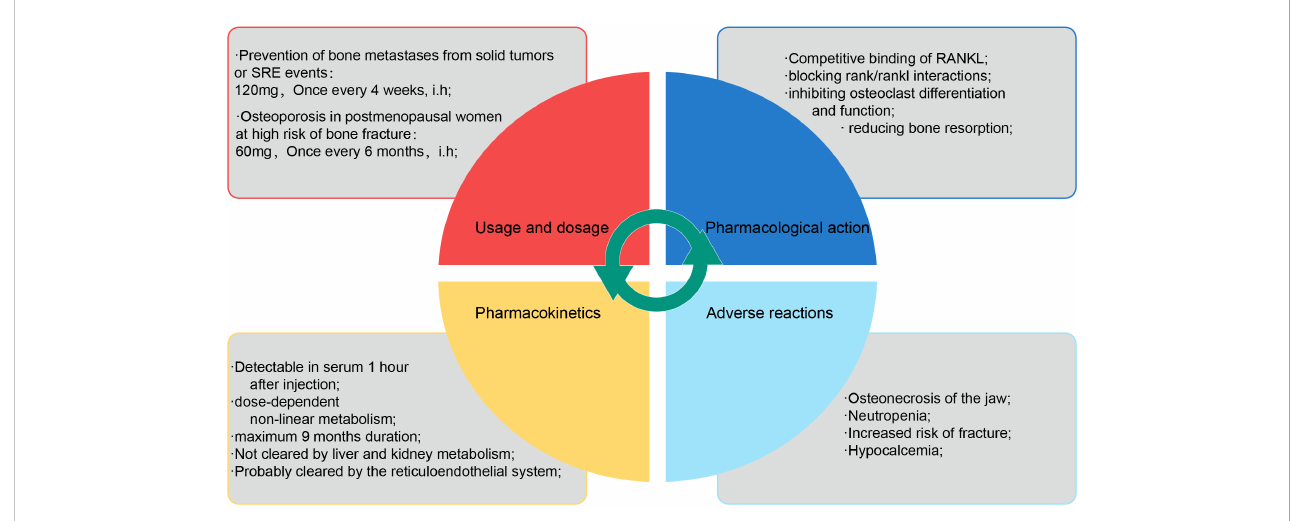
FIGURE 3 The description of denosumab. The properties of denosumab are brie fl y described in four dimensions: usage and dosage, pharmacological mechanism, pharmacokinetics and adverse